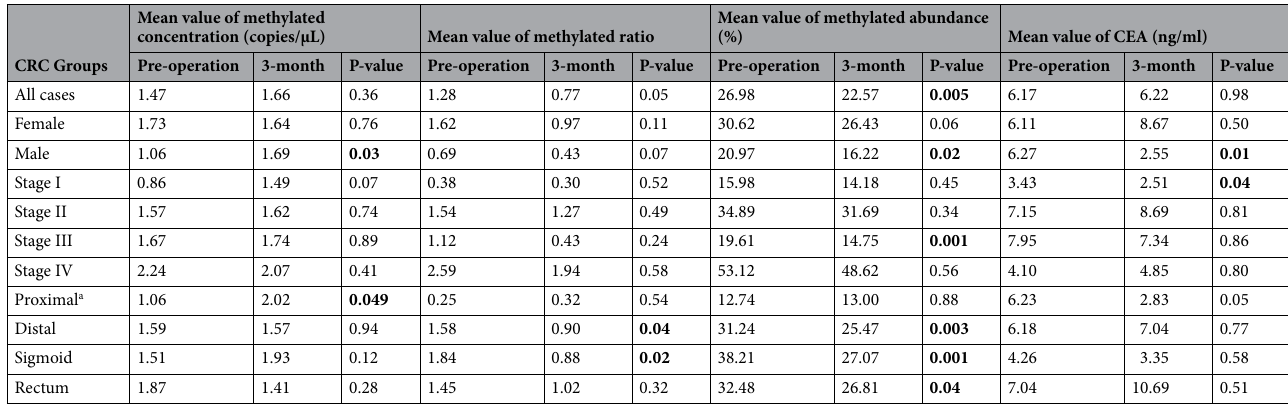
Table 2. SEPT9 methylation and CEA levels in CRC patients pre- and 3-month post-operation. Significant P-values are in bold. SEPT9 septin 9, CEA carcinoembryonic antigen, CRC colorectal cancer. a Proximal referred to cancer above the splenic flexure.